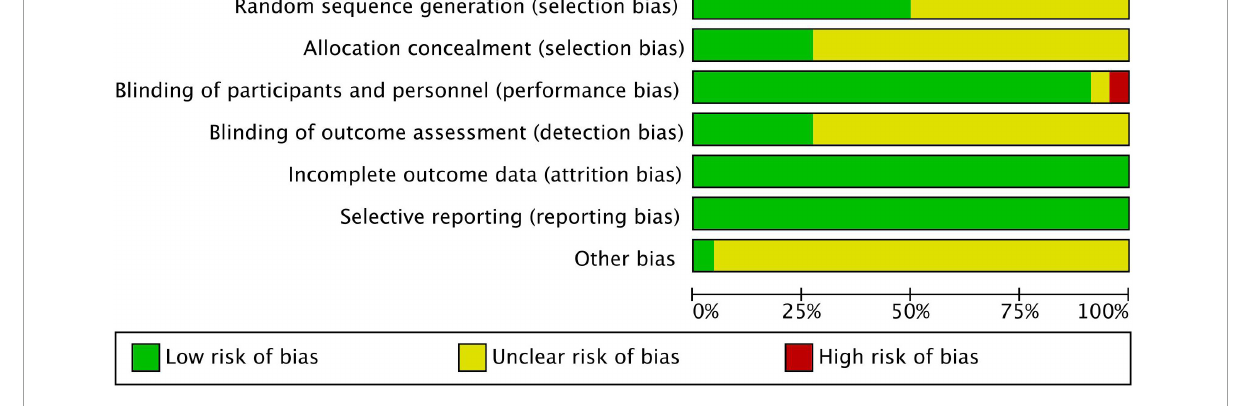
FIGURE3 Risk of bias graph.